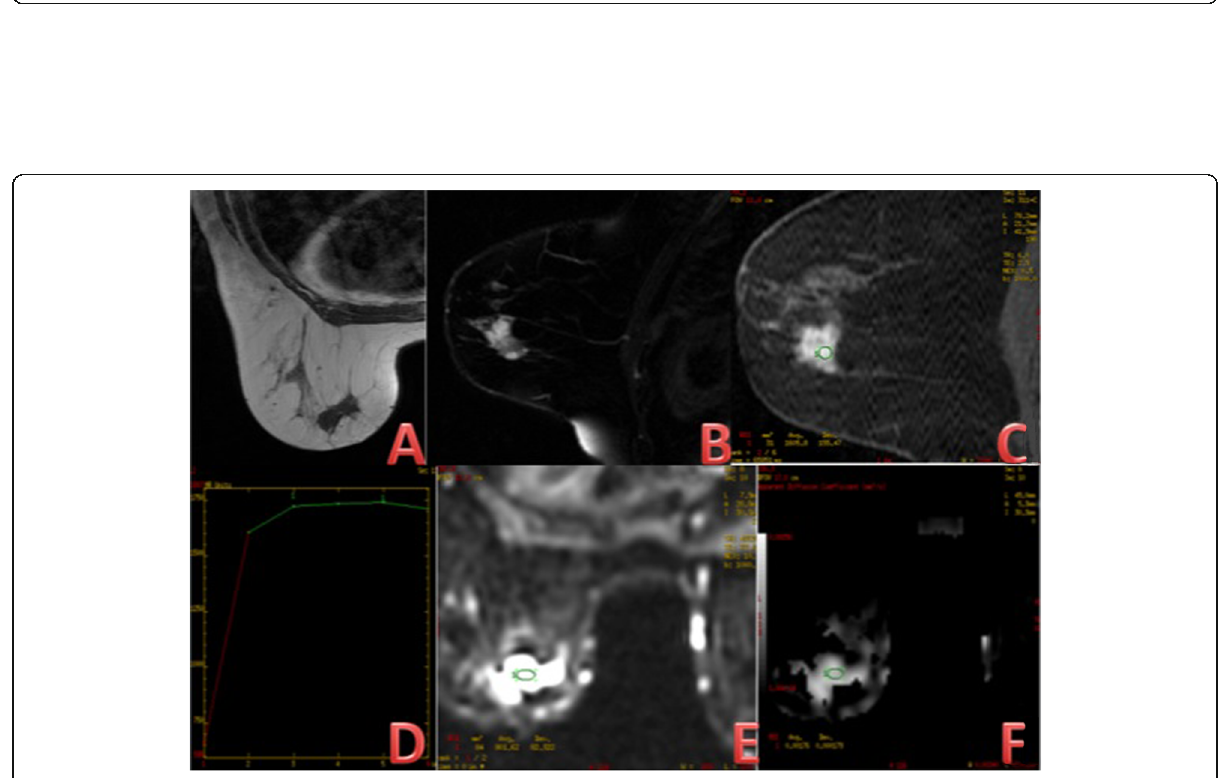
Fig. 2 56-year-old women, mucinous carcinoma, ER (+), PR ( − ) c-erb B2 ( − ), low Ki-67 index, and no axillary pathological lymph node detected on MRI. Breast density is classified as type c on T1WI axial image ( a ). An irregular shaped lesion, measured 35 mm in diameter, is seen on sagittal fat- saturated T2WI (B) and sagittal fat-saturated, post-contrast T1WI ( c ). Kinetic curve of the lesion is type 2 and t peak value is 150 s ( d ). The lesion is hyperintense on DWI ( e ) and hypointense on ADC map ( f